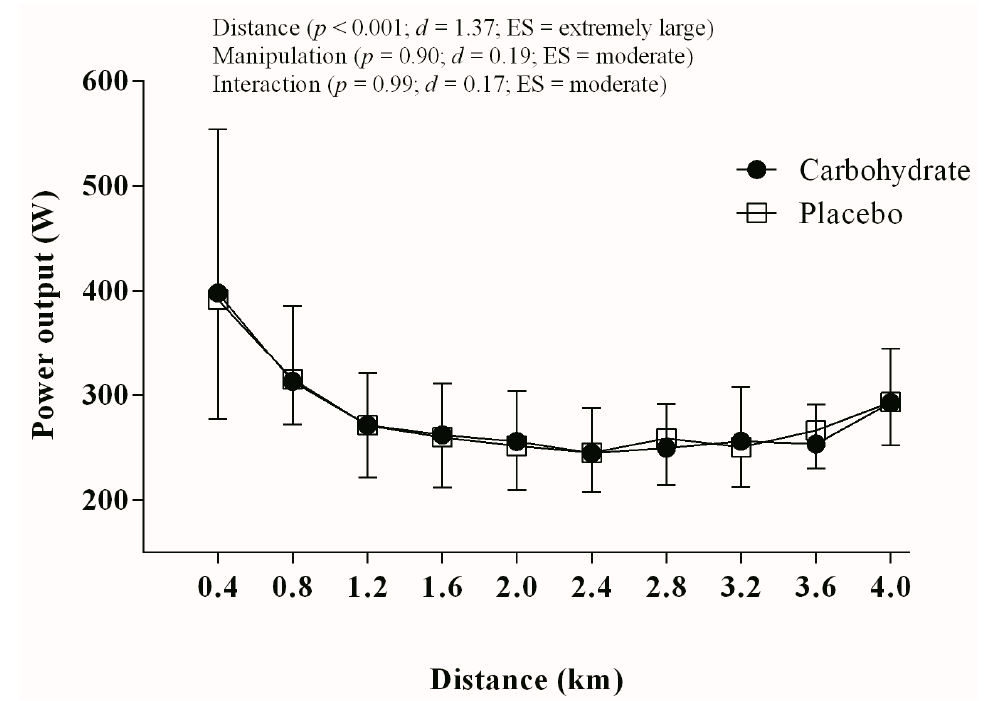
Figure 1. Power output throughout the TT 4km in carbohydrate (filled circles) and placebo mouth rinse (open squares).